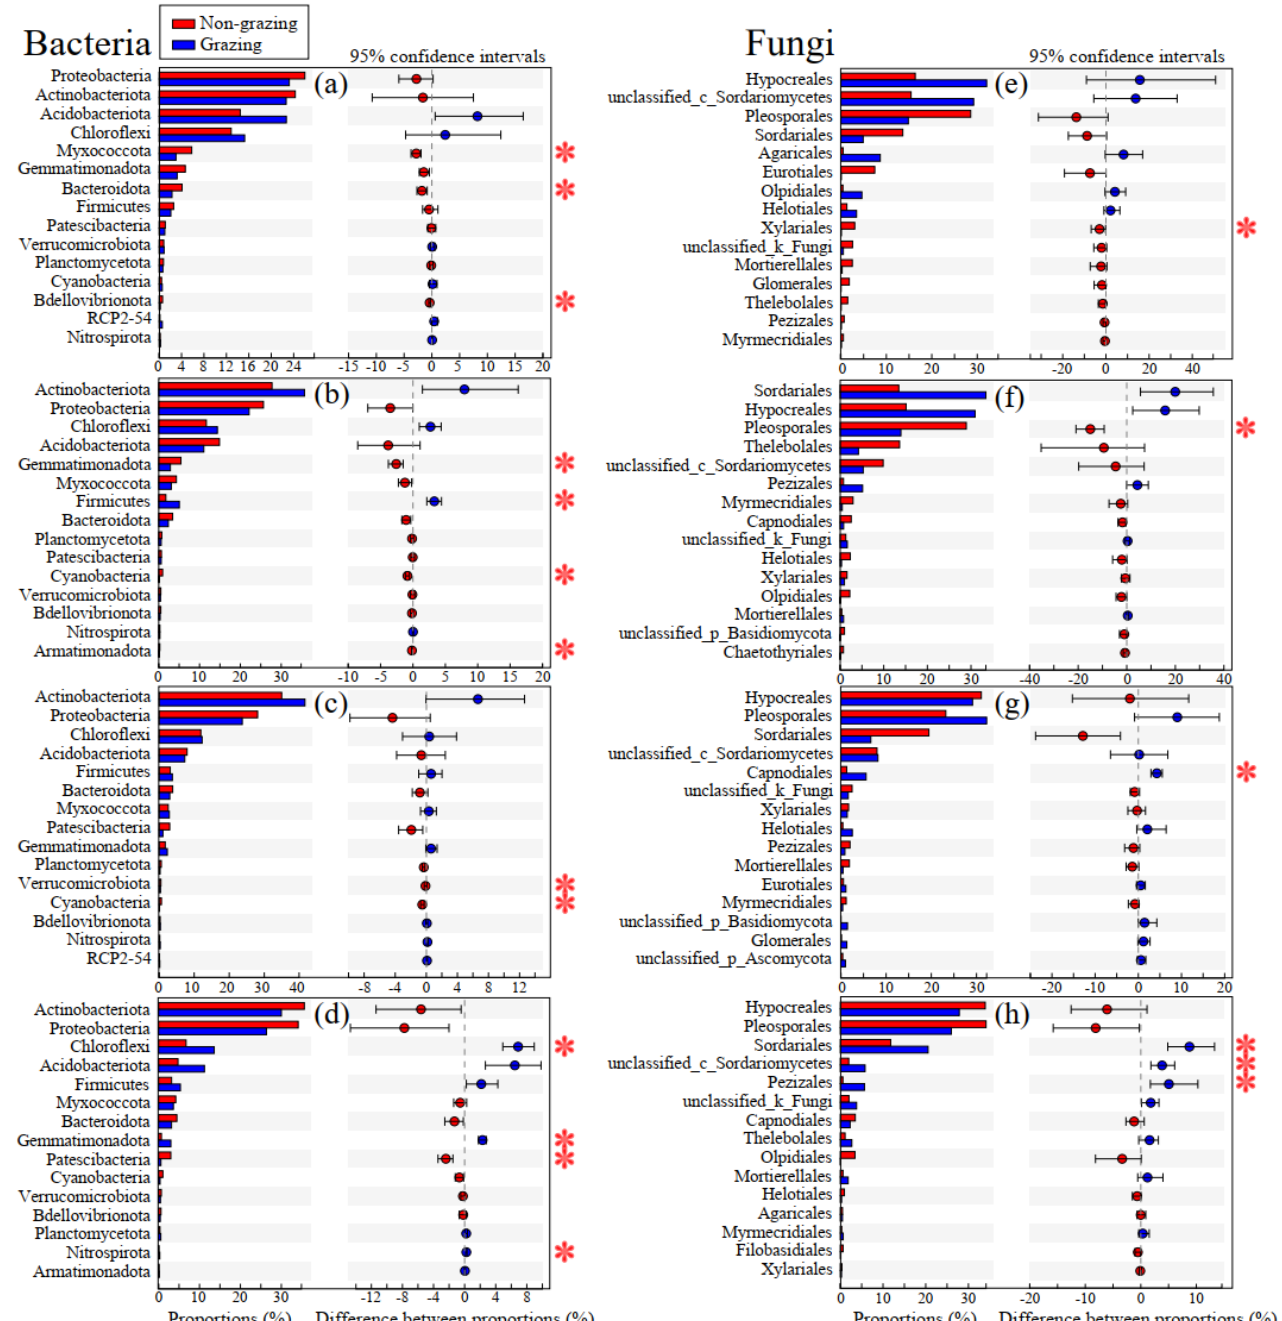
Figure 3. Inter-group difference test of relative abundance of bacteria and fungi in rhizosphere and endosphere compart- ments of L. chinensis at the phylum and order levels, respectively. The relative abundance of bacteria in rhizosphere soil ( a ), root ( b ), stem ( c ), and leaves ( d ) of L. chinensis at the phylum level. The relative abundance of fungi in rhizosphere soil ( e ), root ( f ), stem ( g ), and leaves ( h ) of L. chinensis at the order level. A two-group comparison was used by a Wilcoxon test with a confidence interval of 95%, with FDR adjustment. NG: non-grazed grassland; G: grazed grassland. * p < 0.05.